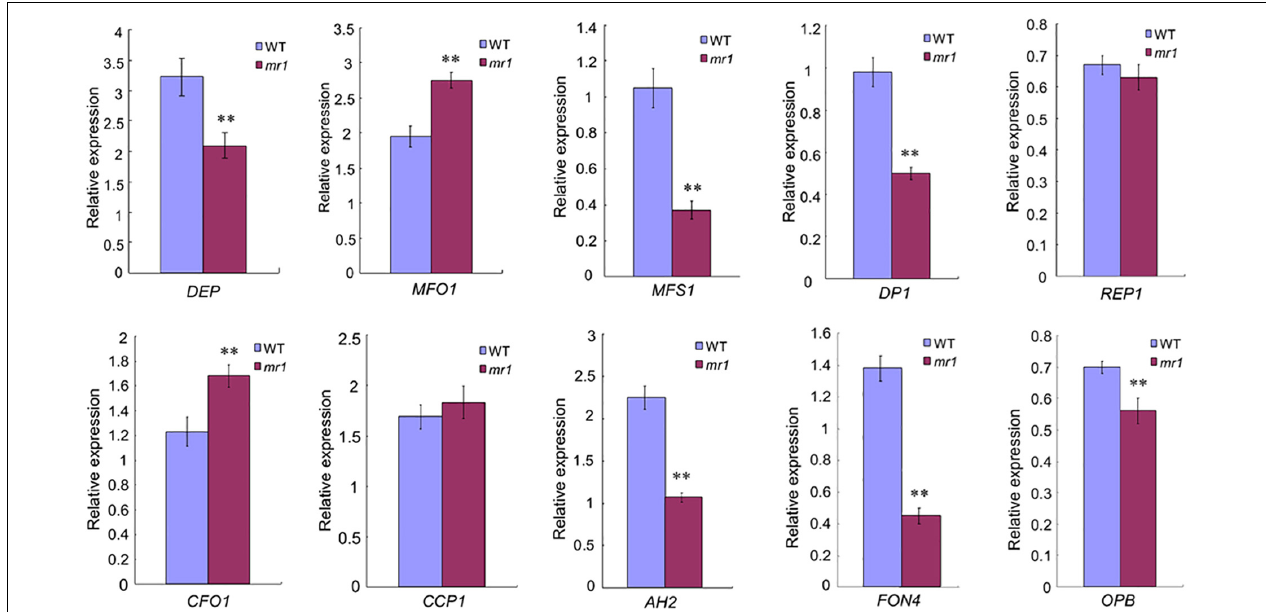
FIGURE 6 | Expression analysis of palea identity-associated genes by qRT-PCR. ∗∗ Significant difference at p < 0.01 compared with the wild-type by Student’s t -test. Error bars indicate SD.